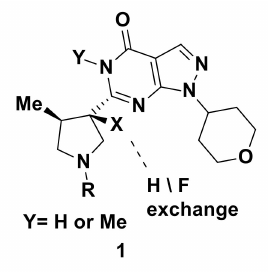
Figure 1. Series of PDE9 inhibitors upon H / F exchange at x